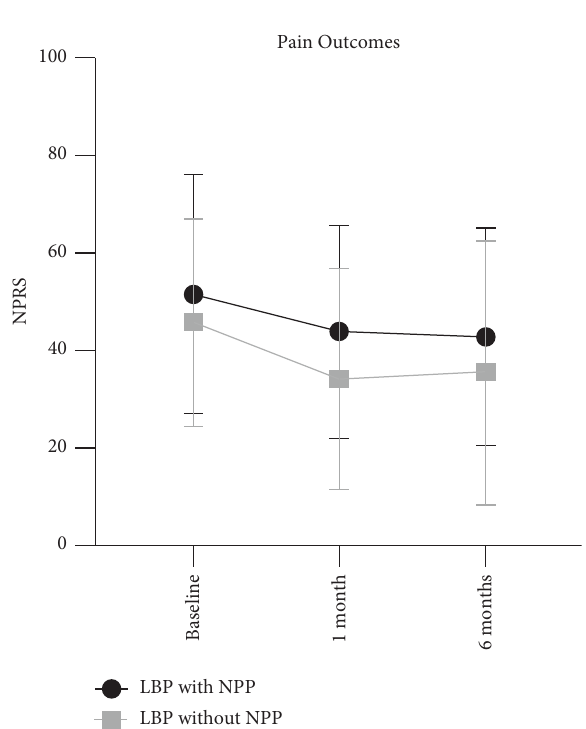
Figure 2: Pressure-pain threshold by NPP.